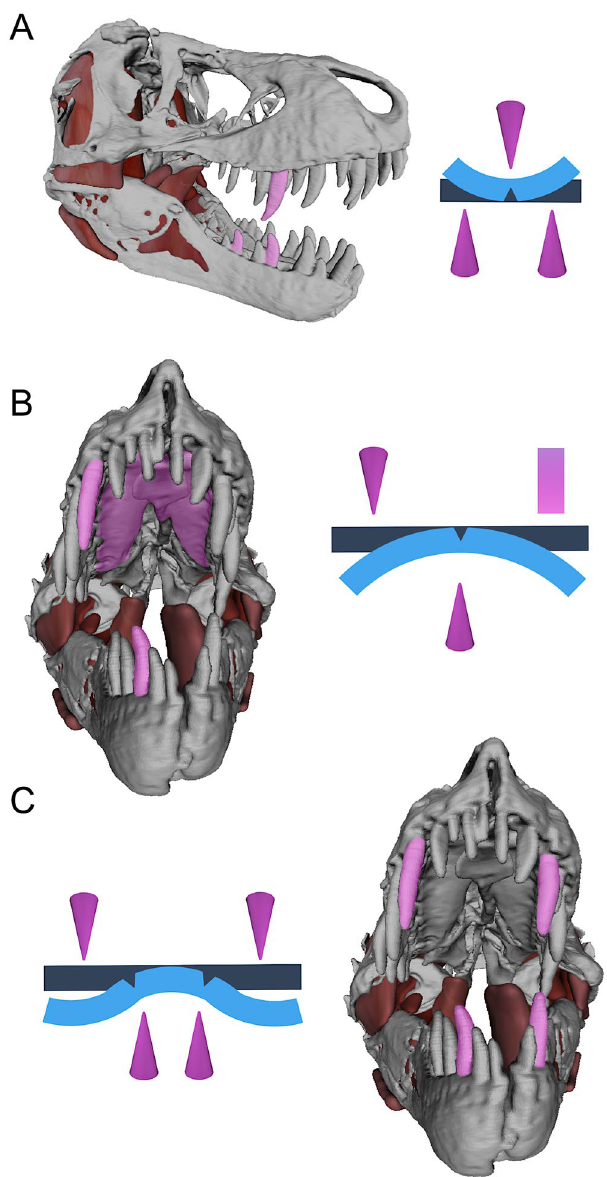
Figure 4. Jaw models of Tyrannosaurus rex paired with idealized beam diagrams, illustrating three- ( A ) (lateral view), ( B ) (anterior view) and four-point (( C ), anterior view) loading configurations that allowed T . rex to promote failure stresses and fracture rigid structures (e.g., bone) without the aid of occluding dentitions. Teeth (cones) and the osseus palate, composed of the right and left maxillae and an anterior expansion of the vomer (rectangle), are shown as contact points in pink; original beam shapes are dark blue; and idealized plastic deformations (exaggerated) are light